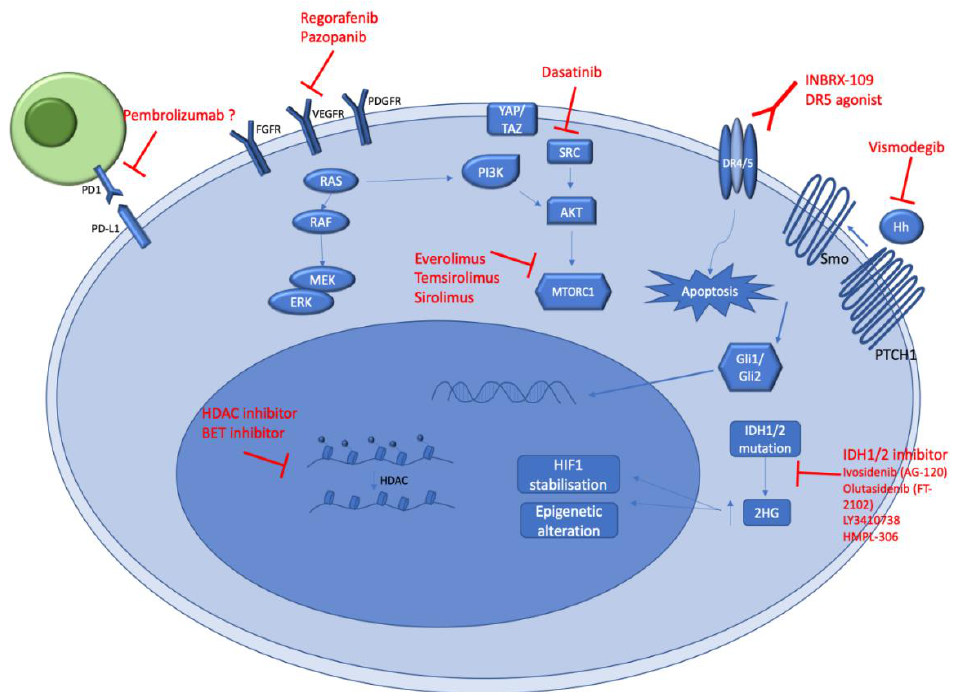
Figure 2. Oncoprint with the most frequently altered genes in conventional and dedifferentiated chondrosarcomas from MSKCC-IMPACT cohort. The oncoprint represents the most common alte- rations in 44 conventional and 14 dedifferentiated chondrosarcomas from the MSKCC impact cohort (taken from cbioportal website, https://www.cbioportal.org (accessed on 17 February 2022)).